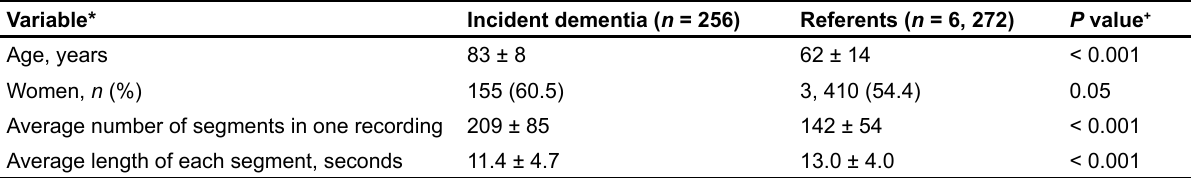
Table 1. Clinical characterization of study